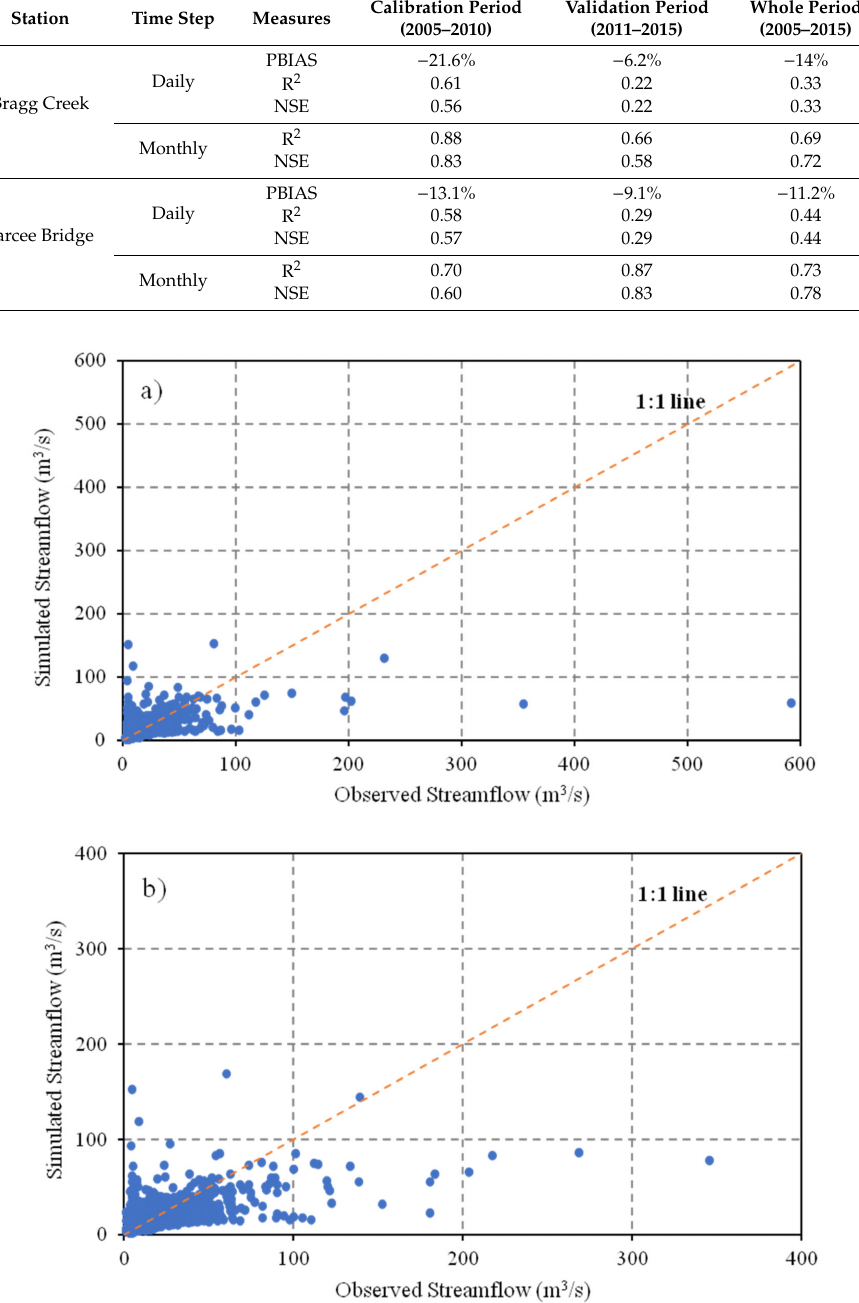
Figure 3. Comparison of simulated and observed daily streamflow for ( a ) Bragg Creek station, and ( b ) Sarcee Bridge